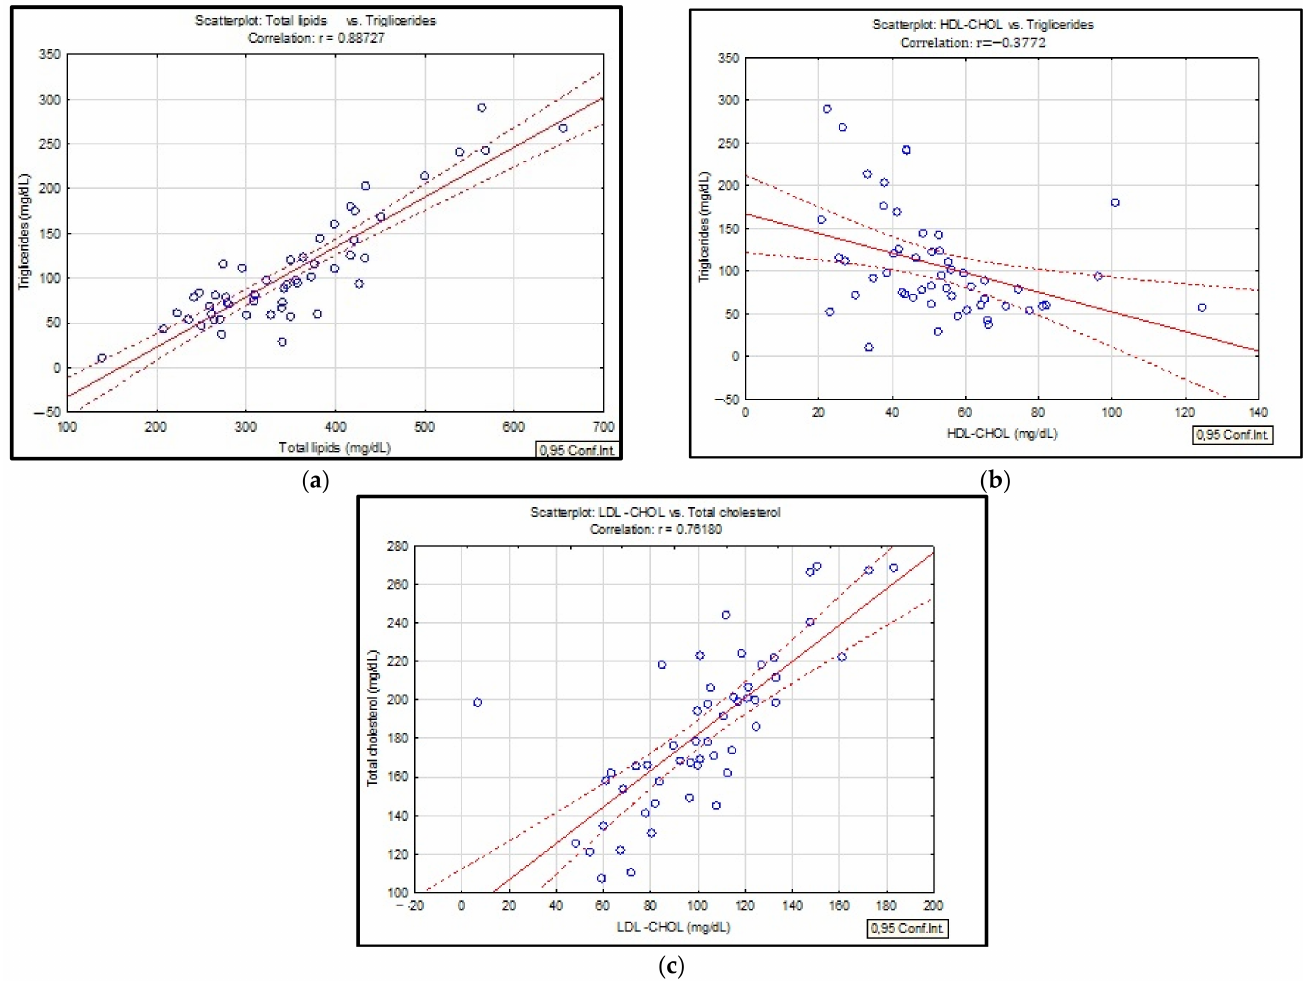
Figure 3. Linear regression between total lipids and triglycerides ( a ); triglycerides and HDL- CHOL ( b ); LDL-CHOL and total cholesterol ( c ) in patients with